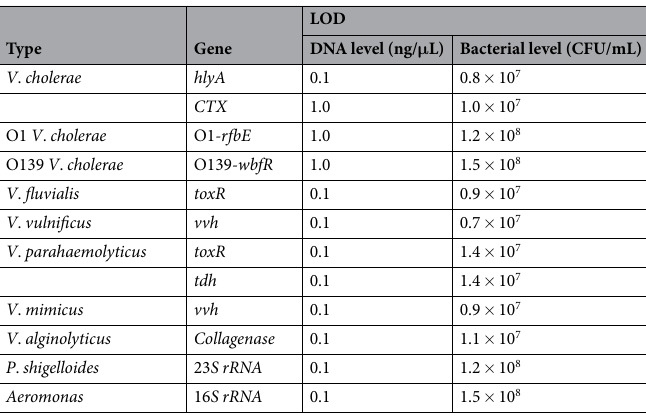
Table 2. The detection limit of the MLMA assay at both the DNA and bacterial